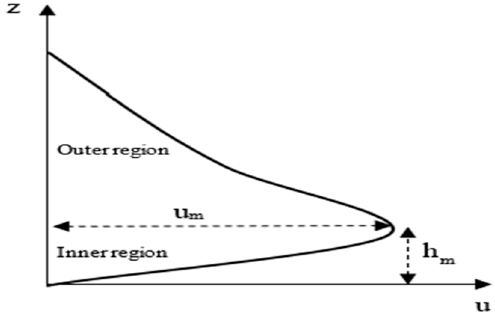
Figure 1. Sketch of a typical vertical velocity profile.